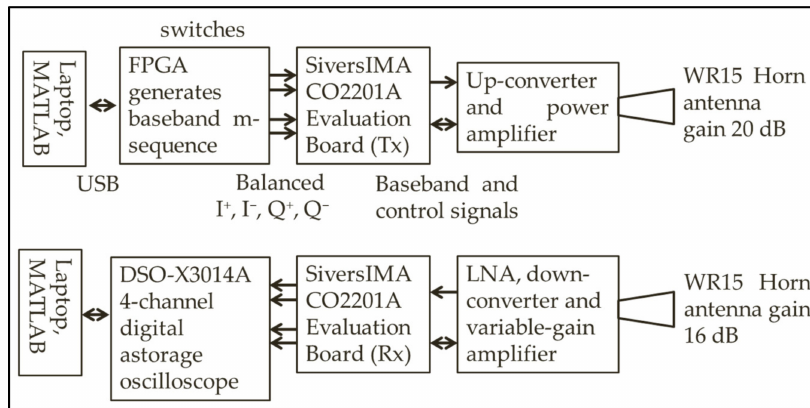
Figure 1. Channel Sounder architecture.